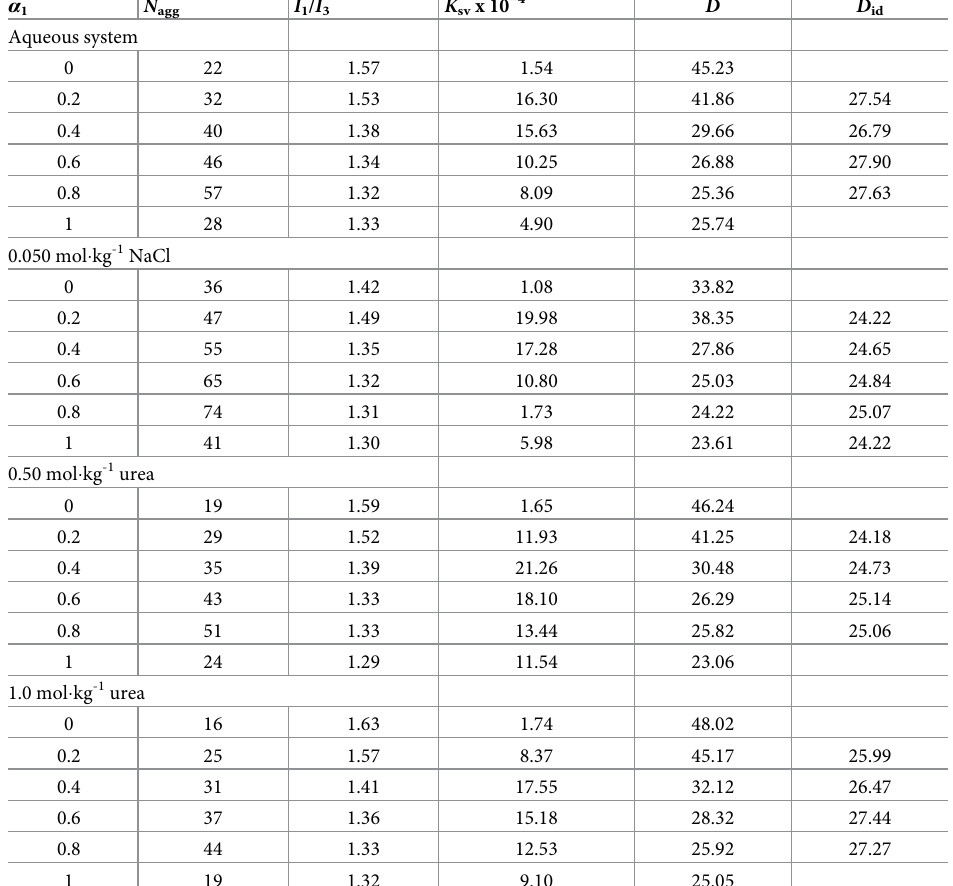
Table 4. Aggregation number ( N agg ) and different associated parameters for AMT+14-E2-14 mixed system in diverse solvent at 298.15